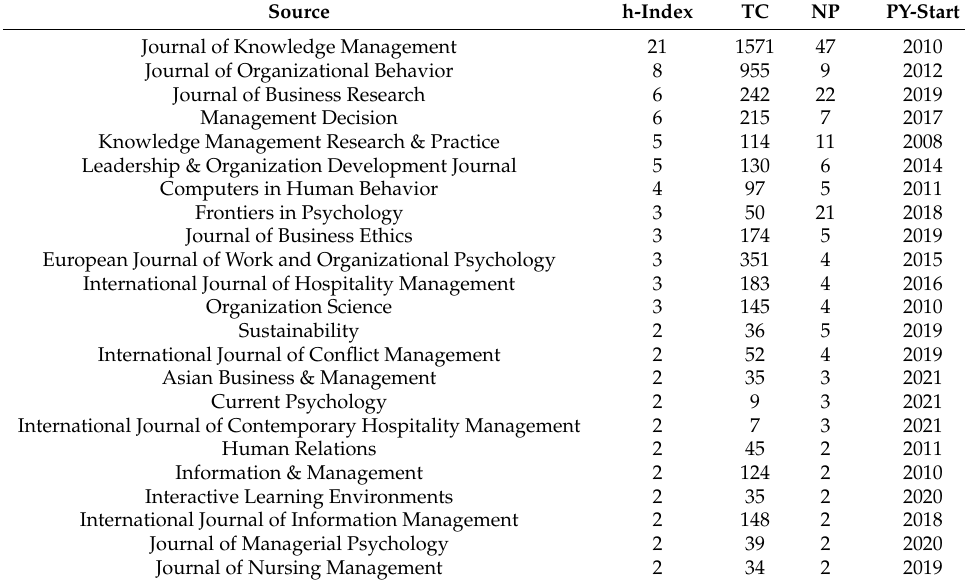
Table 2. Top 20 influential journals.